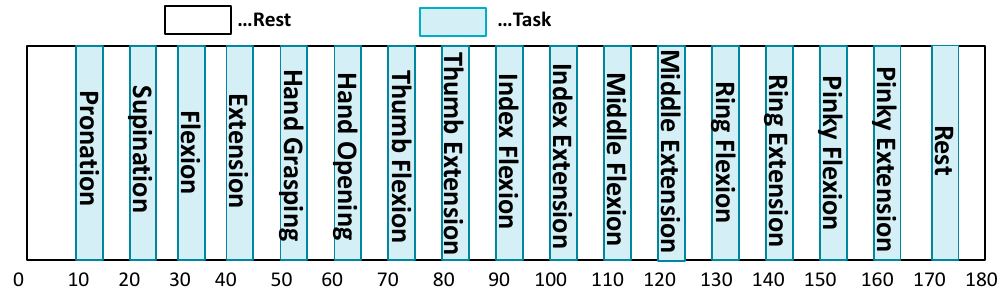
Figure 8. Execution sequence of 17 motions (including rest state). Each motion is executed for five seconds with a five second resting interval in between each motion. The total duration of each run is 180 s. The feature point for rest state is selected between 170 and 175 s.